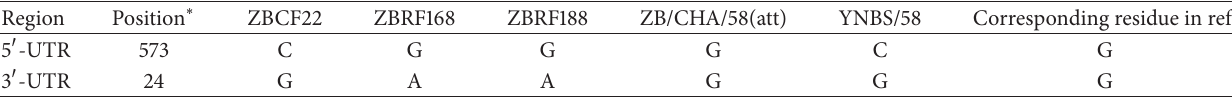
Table 2: Nucleotide mutations of ZBCF22 and their attenuated strains in untranslated regions (UTRs) † . Region